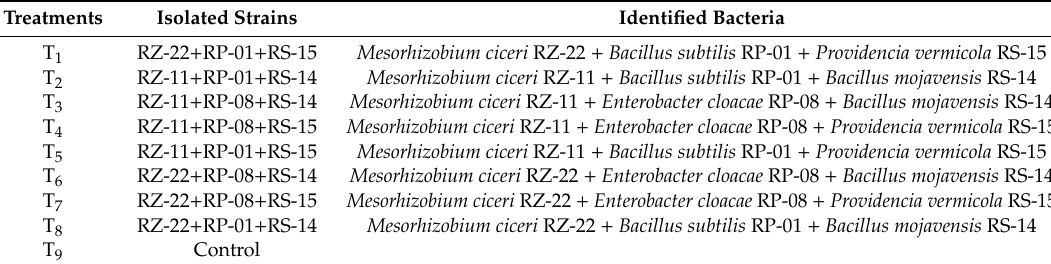
Table 6. Detail set of treatments in glass house experiment on